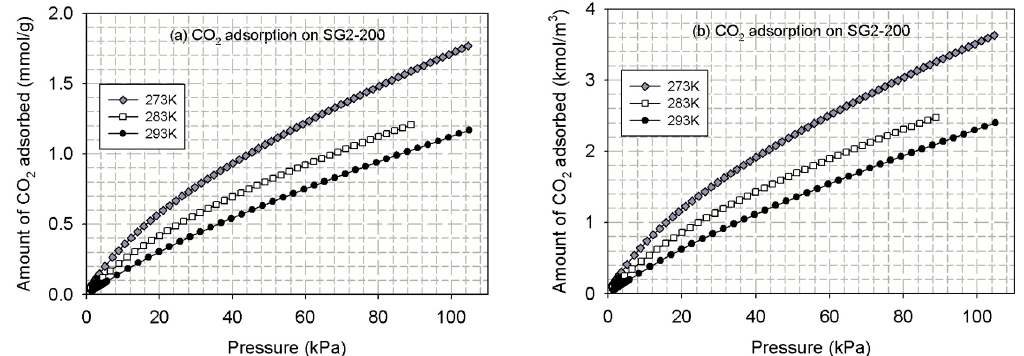
Figure 10. Experimental CO 2 adsorption isotherms at 273, 283 and 293 K for the prepared porous glass, ( a ) adsorbed amount plotted in mmol/g and ( b ) adsorbed amount plotted in kmol/m 3 .